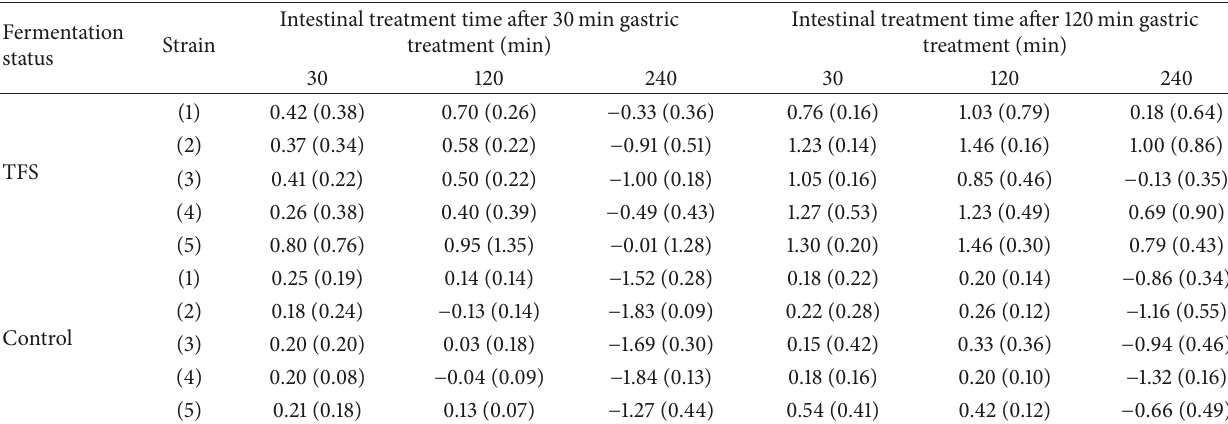
Table 4: Reductions of E. coli during intestinal treatment ∗ .